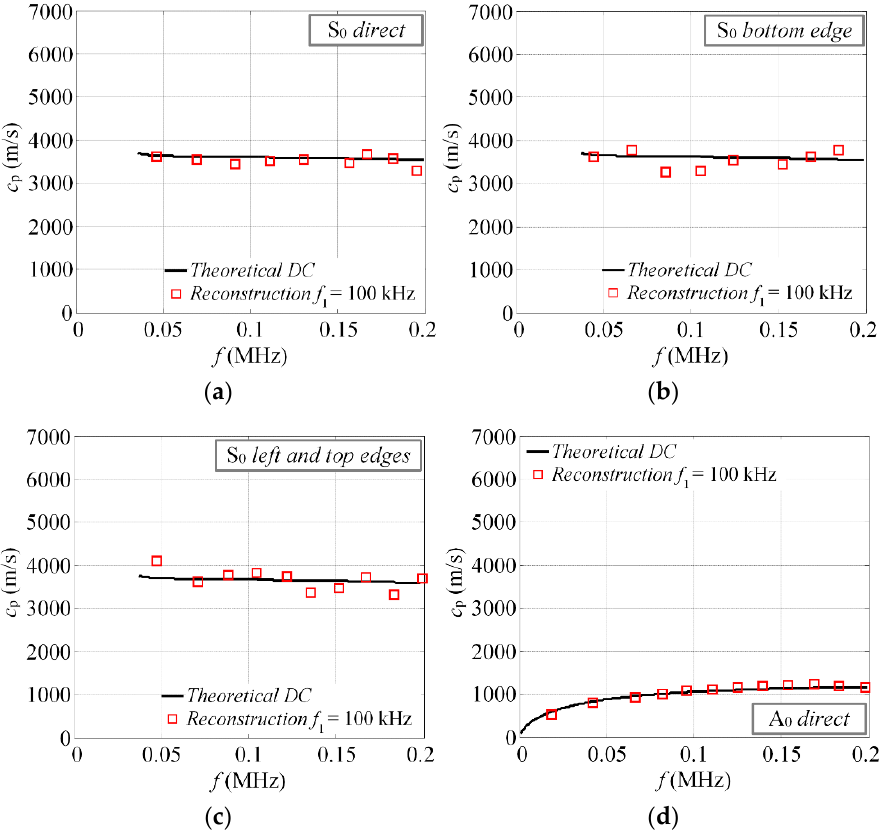
Figure 11. The experimental waveforms obtained on the GFRP sample along the propagation path, at distances ( a ) d 1 and ( b ) d 2 .